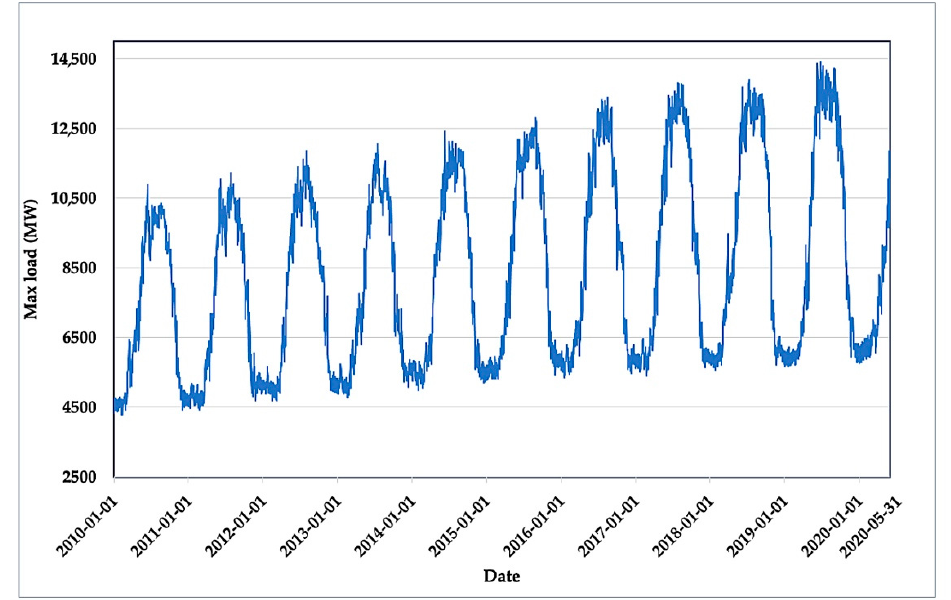
Figure 1. Actual maximum load of Kuwait between January 2010 and May 2020.